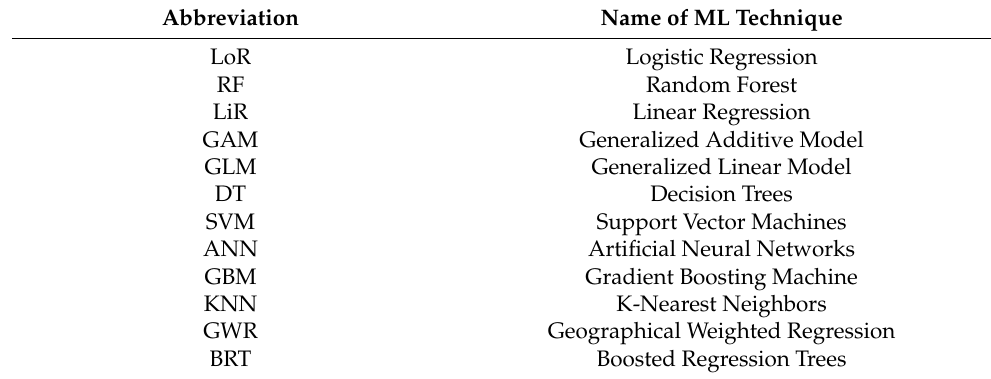
Table 1. Most common ML techniques for predictive purposes